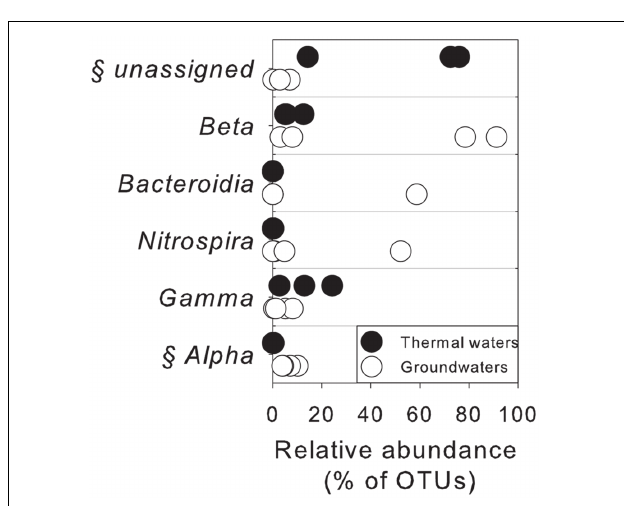
FIGURE 5 | Microbiological variables that more significantly explained the overall dissimilarity (according to SIMPER test) between thermal waters and groundwaters at the class level. §, statistically different between two groups of water according to NPMANOVA analysis ( p < 0.05).